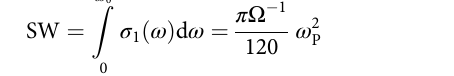
ffiffiffiffiffiffiffiffiffiffiffiffiffiffiffiffiffiffiffiffiffiffiffi p (cid:1) h ω (cid:3) Δ = (cid:1) h ω Fermi distribution, (cid:1) h is Planck ’ s constant divided by 2 π , k B is the Boltzmann constant. Fitting the experimental absorption coef fi - cient using the equation above, we fi nd E inter ~100 meV as indi- cated by the dashed line in Fig. 1c.